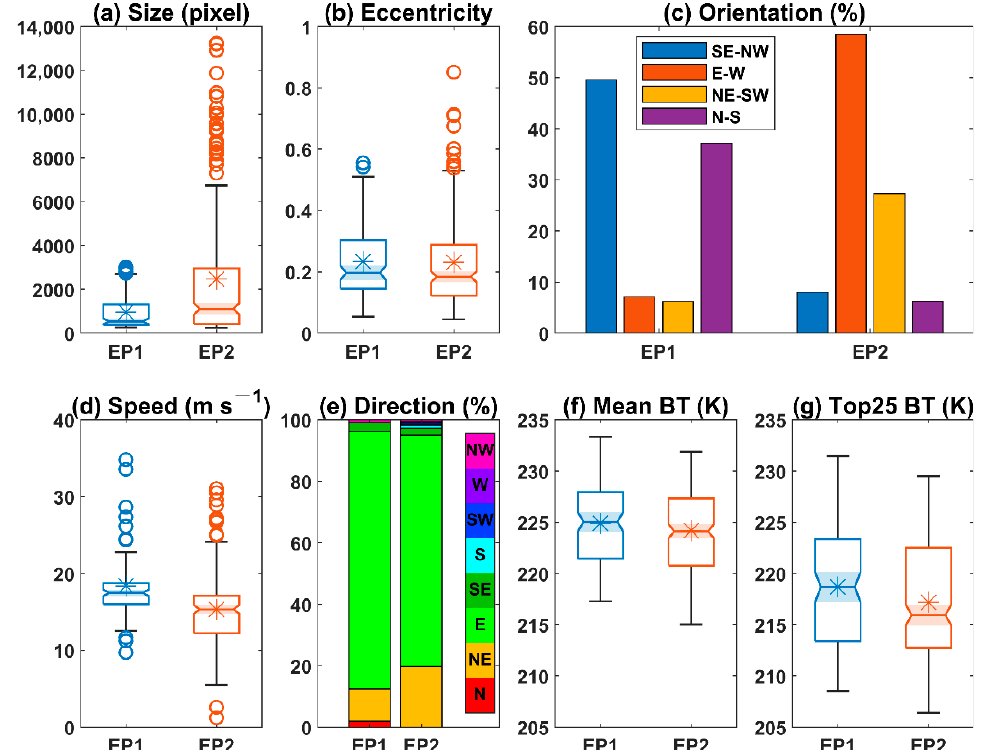
Figure 9. Comparison of the MCS features between EP1 and EP2 in terms of the ( a ) size (satellite pixel), ( b ) eccentricity (smaller magnitude indicates a more linear shape), ( c ) orientation, ( d ) speed and ( e ) direction of movement, ( f ) brightness temperature (BT) average of all pixels of each MCS sample, and ( g ) BT average of the coldest 25% pixels of each MCS sample. When examining the MCS motion, only the MCS samples without a merging or splitting process were considered, to avoid the unreliable motion caused by the sudden displacement of an MCS sample. The boxplot style is similar to that in Figure 1. The asterisk symbol within the box denotes the sample average.